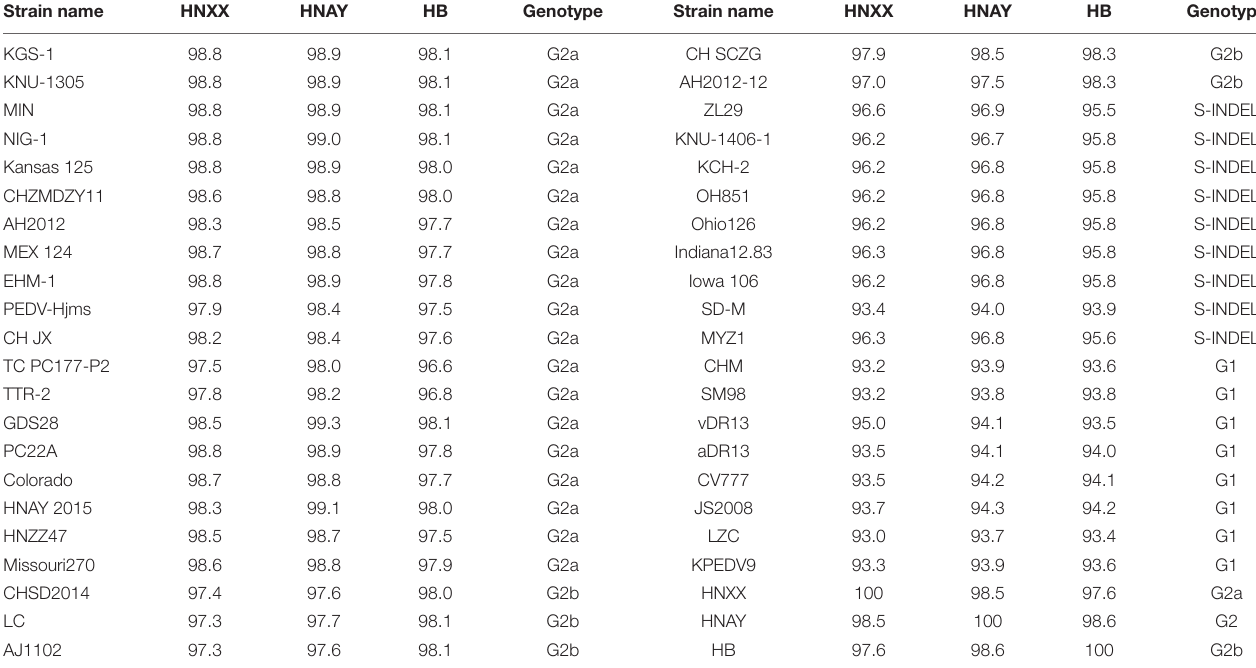
TABLE 3 | Nucleotide sequence identity (%) of S genes of different PEDV strains.